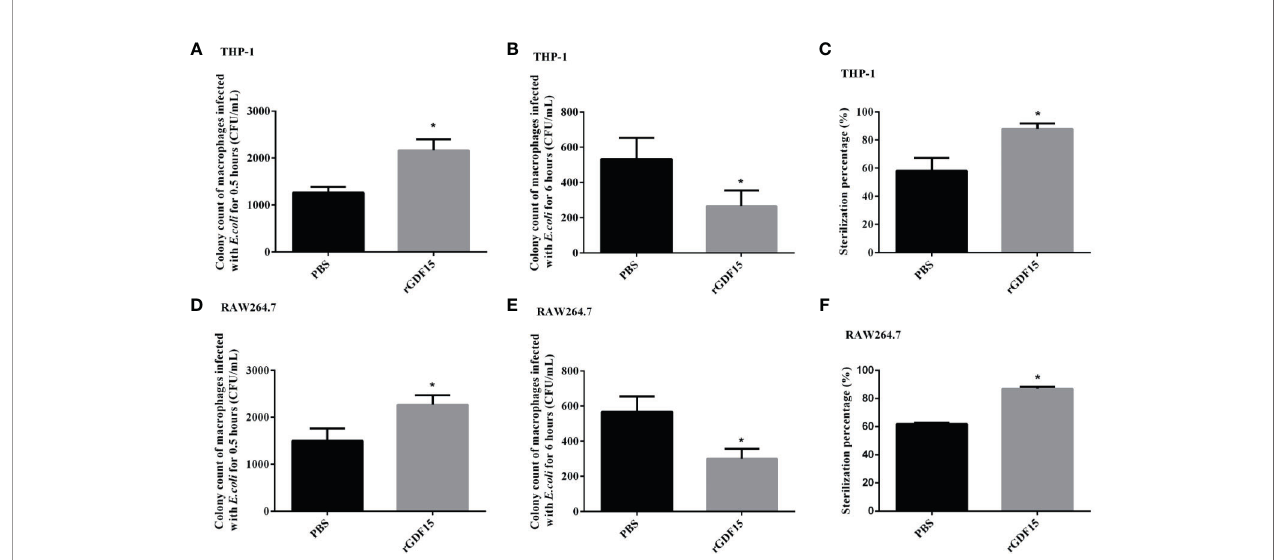
FIGURE 12 | The phagocytosis of macrophages was identi fi ed by E. coli infection, and the bactericidal function was determined by gentamicin protection assay. RGDF15 enhanced the phagocytosis of THP-1 (A) and RAW264.7 (D) cells; it also improved the bactericidal function of THP-1 (B, C) and RAW264.7 (E, F) cells. * P < 0.05, compare with the PBS